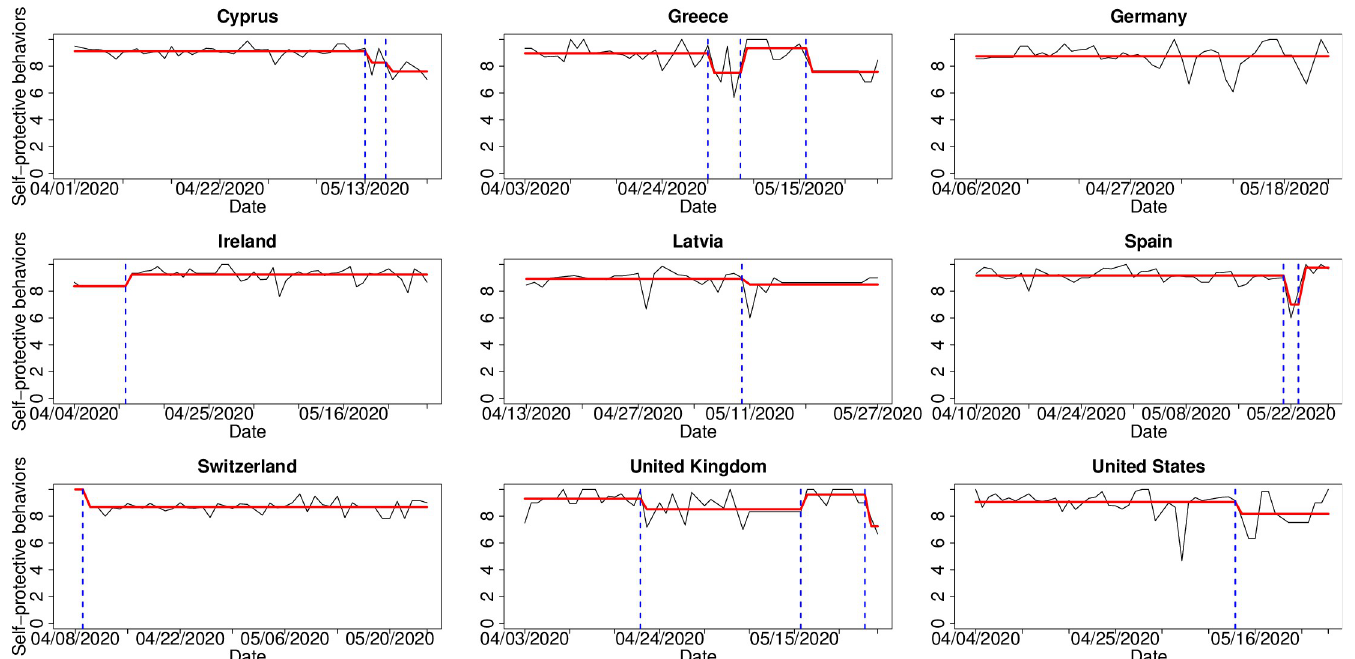
Fig 2. Results of the change-point detection analysis for the self-protective behaviors variable in nine countries. The real data are given with black colored line, while the estimated piecewise-constant signal is the red colored line. The estimated change-point locations are given with dotted, blue vertical lines.